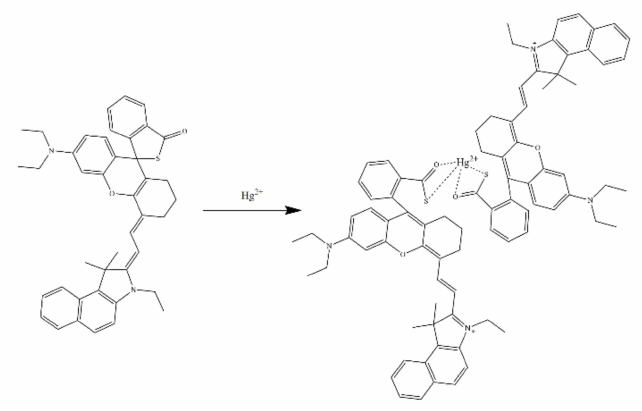
Figure 11. The proposed sensing mechanism of CCS-Hg (Table 1, No. 15) [47]. Zhang Q., et al. designed a rhodamine-based sensor for selective detection of Hg 2+ via the FRET mechanism (Table 1, No. 16) [48]. The synthesized material possessed great pseudo-Stokes (174 nm) in the presence of Hg 2+ and showed fluorescent and ratiometric response with a fast reaction time (less than 30 s) (Figure 12). The limit of detection for Hg 2+ was found to be 0.38 × 10 − 6